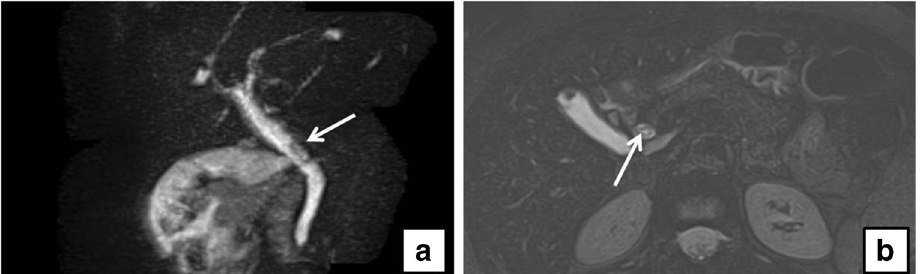
Fig. 1 a Sagittal thick-slab magnetic resonance cholangio- pancreatography (MRCP) shows a filling defect in a dilated common bile duct (CBD) ( arrow ). b Axial fat-saturated T2-weighted magnetic